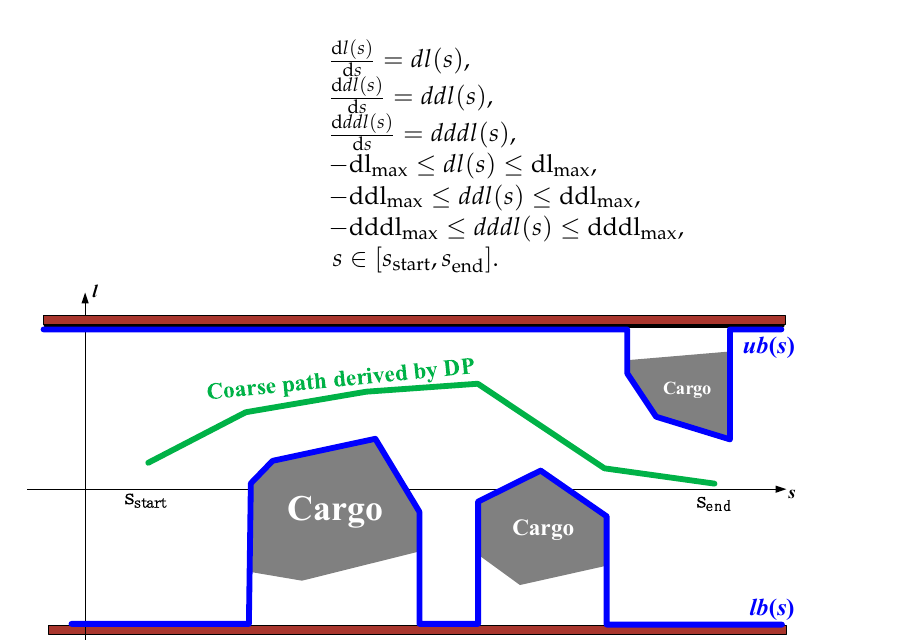
Figure 6. Schematics for the construction of left/right bounds in EM planner.